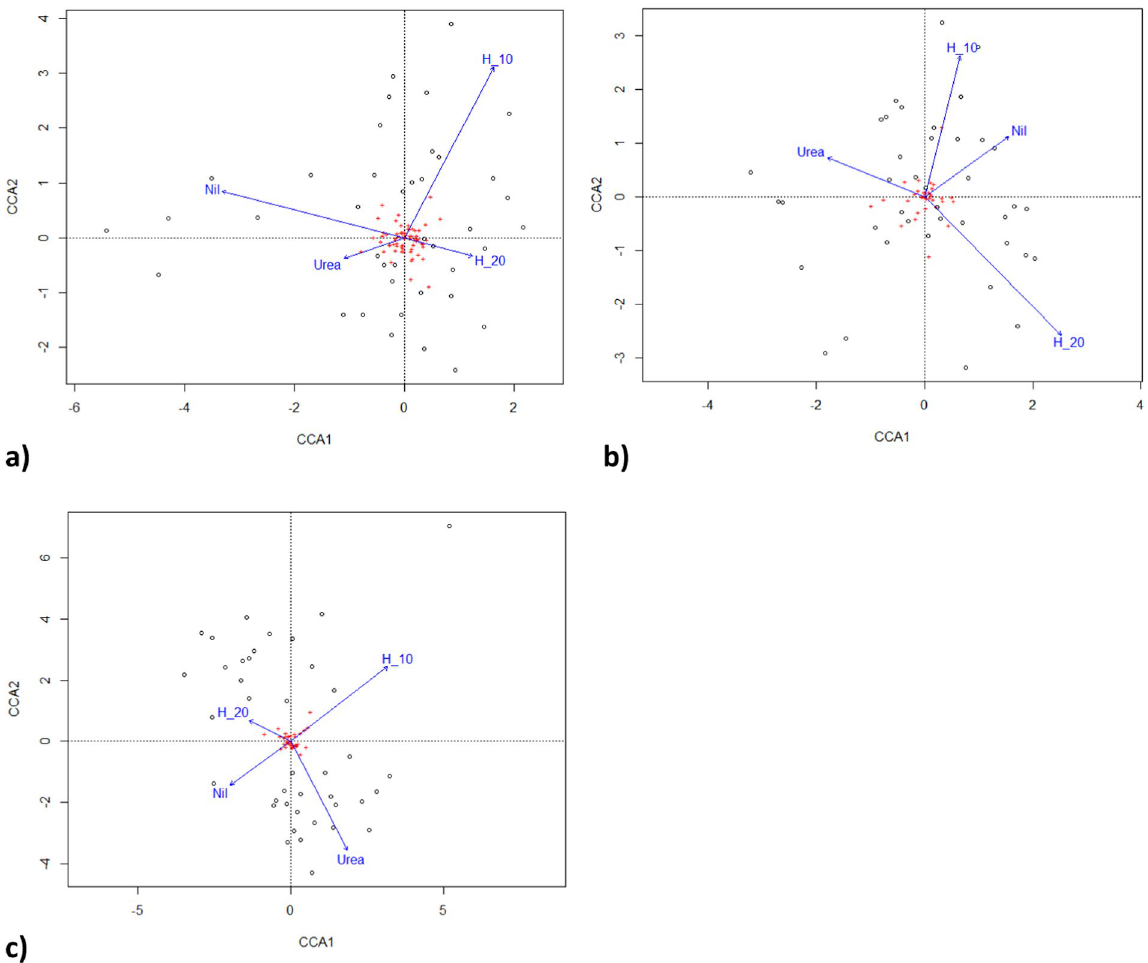
Figure 4. Canonical correspondence analysis of urea and humate rate (H) effect on ( a ) fungi, ( b ) bacteria, ( c ) gammaproteobacteria. Blue vector lines indicate direction and strength of fertiliser interactions, circles = fertiliser plots, crosses = taxa, H = %